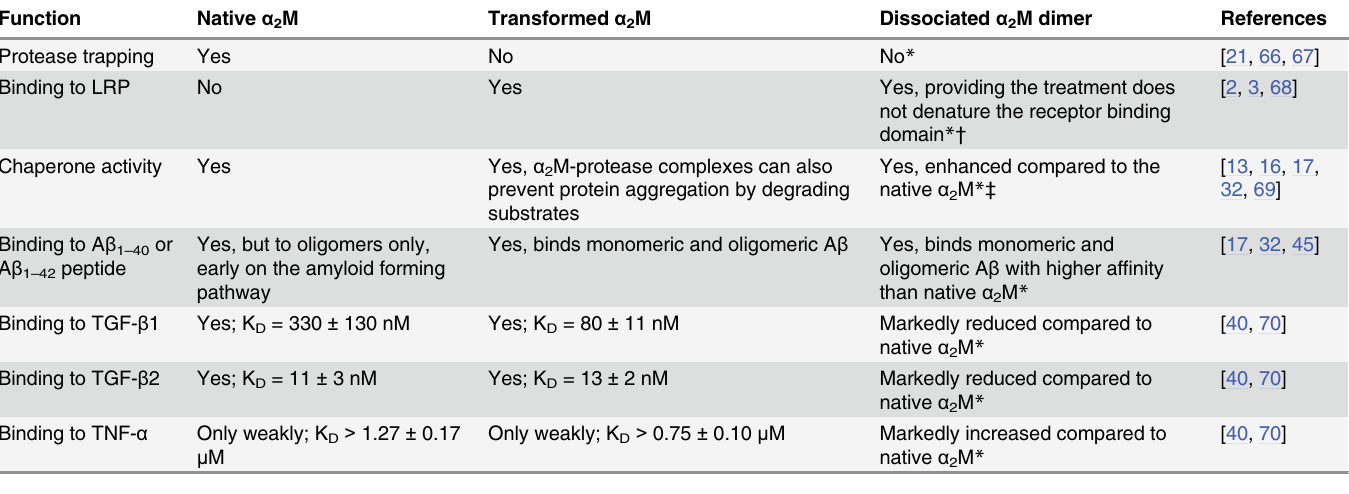
Table 1. Examples of conformational dependent α 2 M activities. Many of the activities of α 2 M are dependent on whether or not the protein is in its native conformation or in its transformed state. Additionally, dissociation of the native α 2 M tetramer into dimers (that can be induced using several different chemical methods) has also been demonstrated to influence the activities of α 2